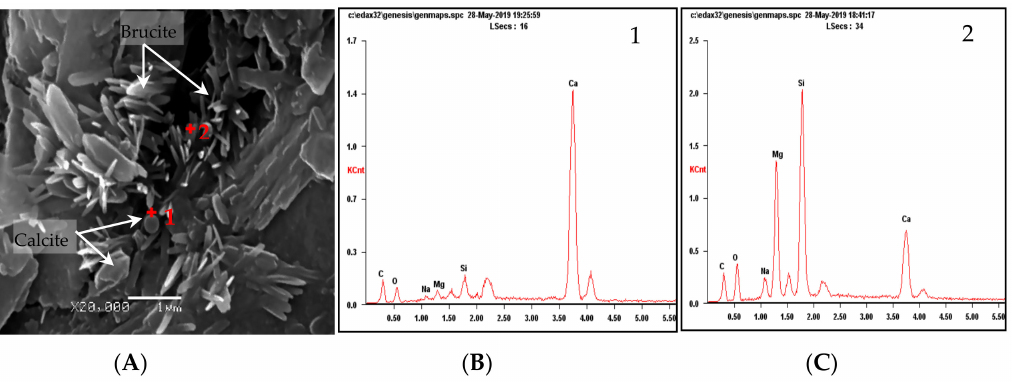
Figure 13. SEM and EDS images of products in concrete bars cured in 1 mol / L NaOH at 80 ◦ C: ( A ) SEM image of the products; ( B ) EDS image of calcite; ( C ) EDS image of